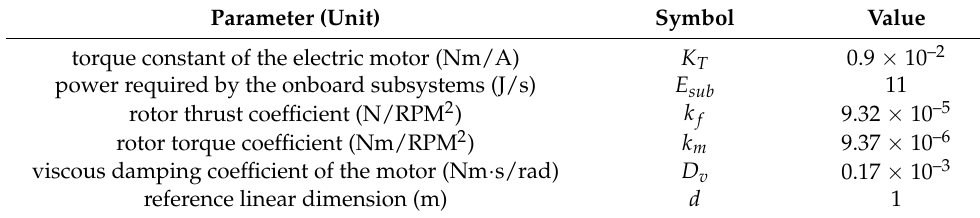
Table 3. Motor model parameters used in the numerical simulation. Parameter (Unit)